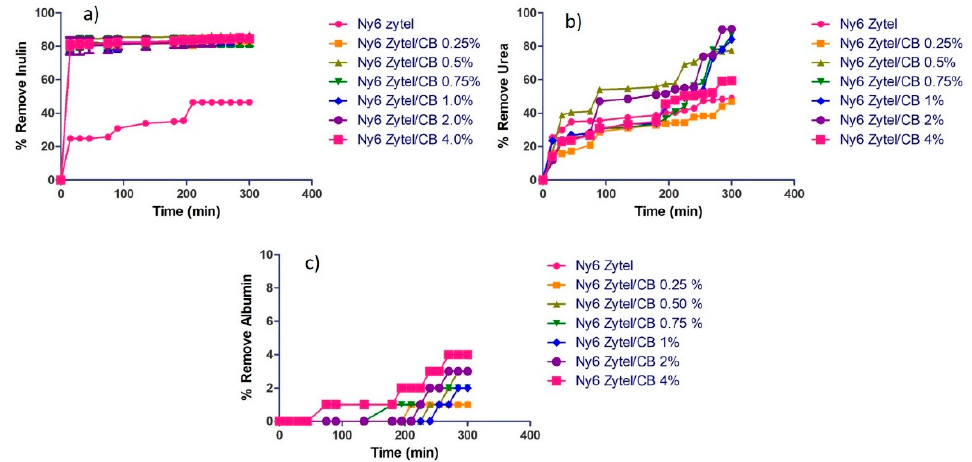
Figure 8. Removal percentage of ( a ) inulin, ( b ) urea, and ( c ) albumin.